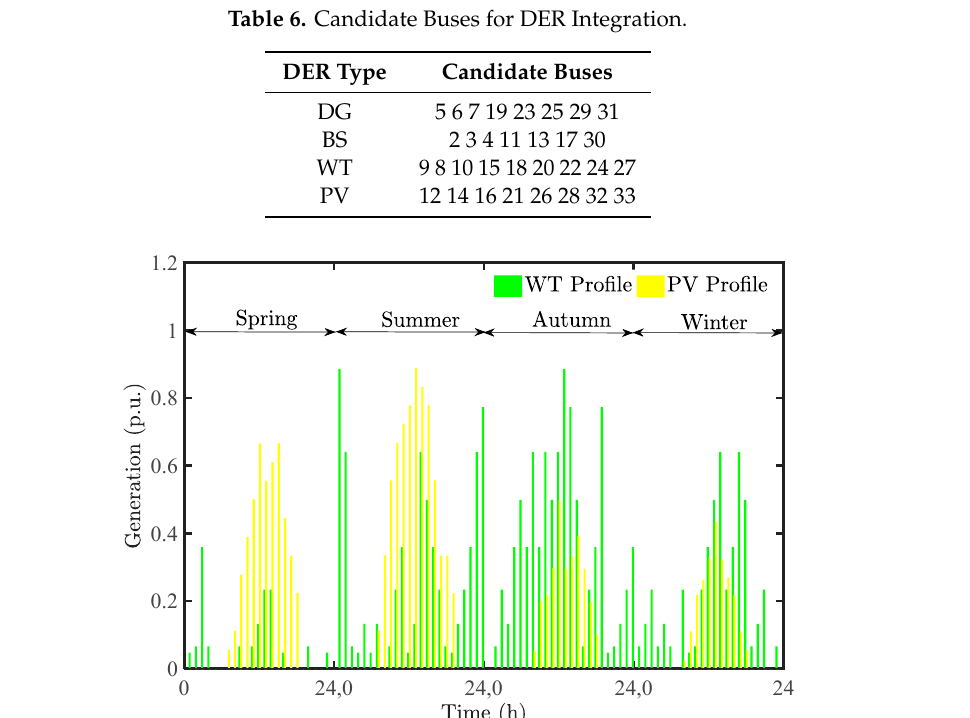
Figure 5. Typical generation profiles of WTs and PVs in four seasons.